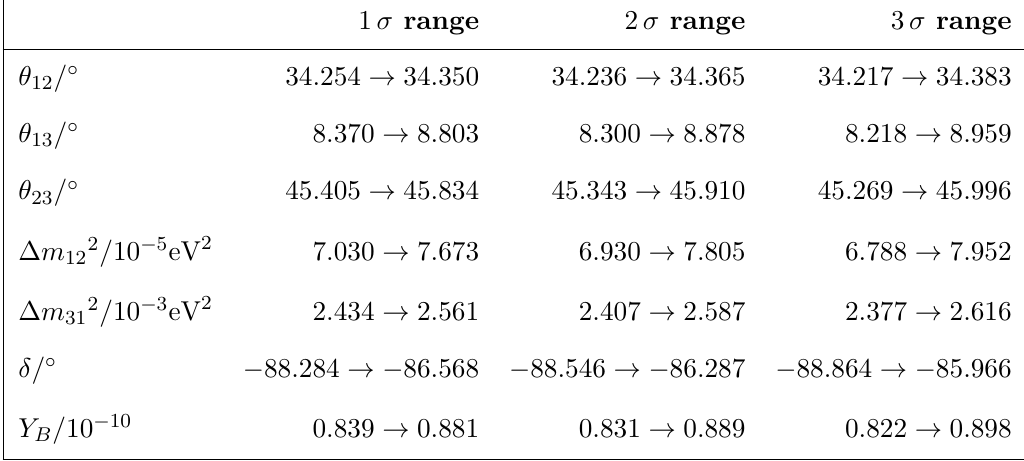
Table 4 . Ranges of observables for Case A2 .